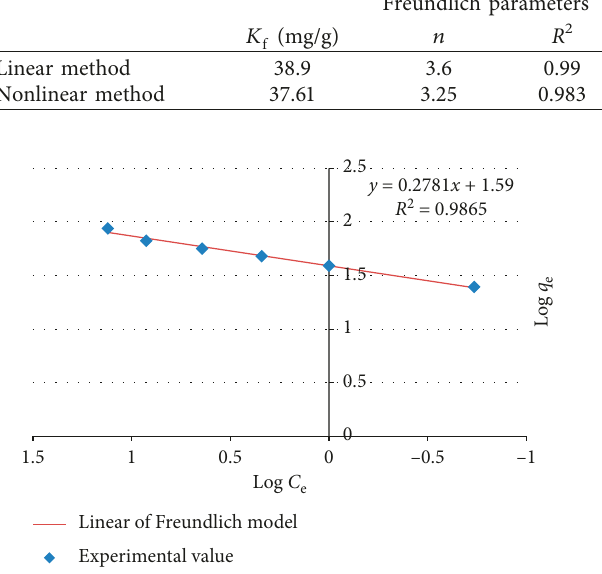
Figure 10: Freundlich isotherm of RB on Fe 60min, pH of the solution